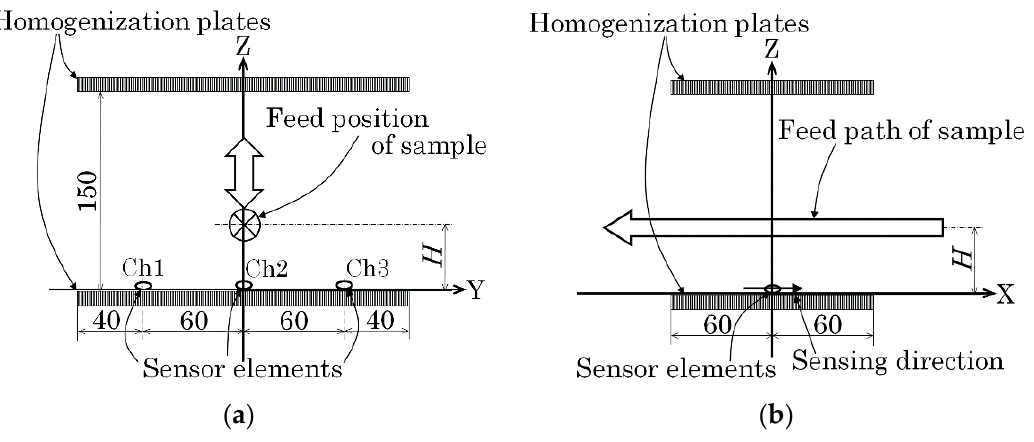
Figure 14. Schematic explanation of the measurement layout (first experiment). ( a ) Front view (View point of feeding sample). ( b ) Side view.